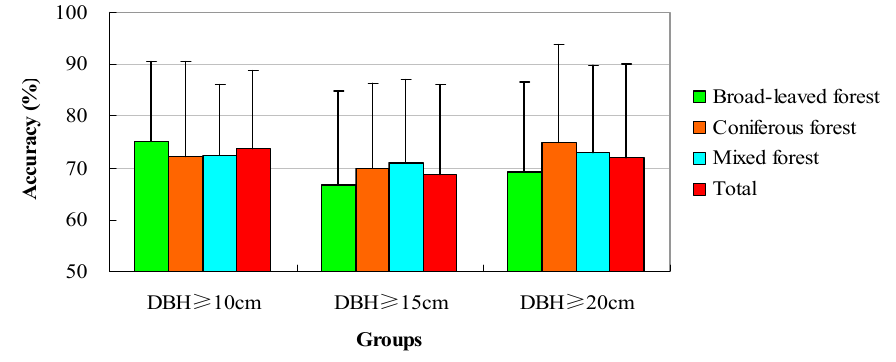
Figure 3. The difference in accuracy between forest types for the three groups.